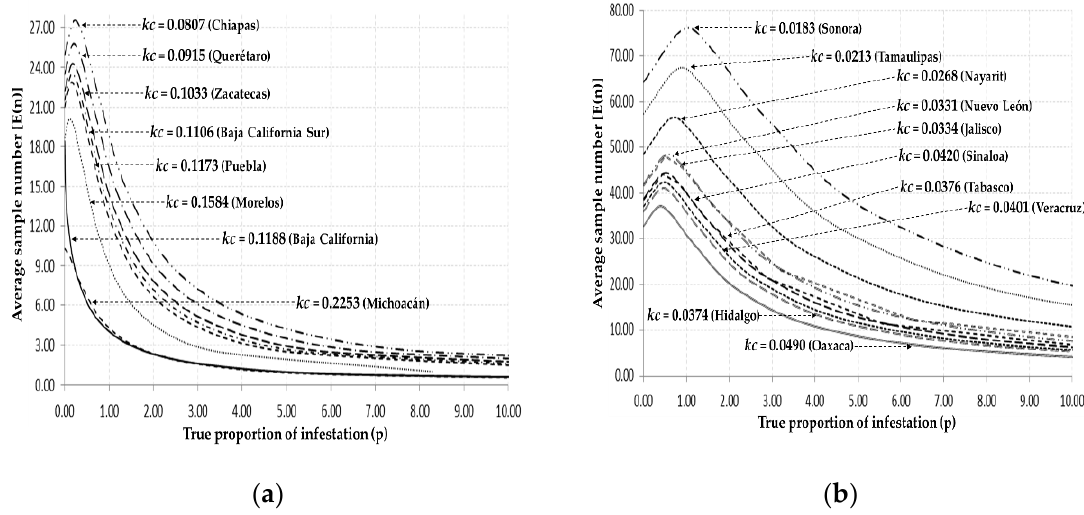
Figure 3. Average Sample Number (ASN) function of the SPRT sequential sampling plans for the Asian citrus psyllid for 18 citrus producing states of Mexico. α = 0.1, β = 0.1, and threshold= 0.2 adults/trap. ( a ). kc ≤ 0.05. ( b ). kc > 0.05.